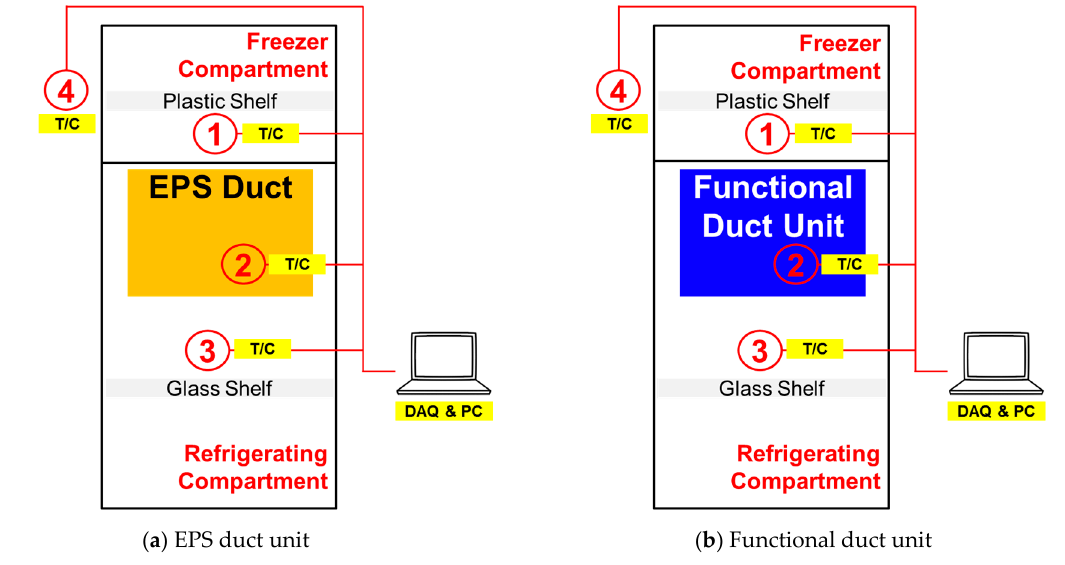
Figure 4. Pre ‐ selected locations for temperature measurements of refrigerators e quipped with EPS Figure 4. Pre-selected locations for temperature measurements of refrigerators equipped with EPS duct duct unit and FDU. unit and